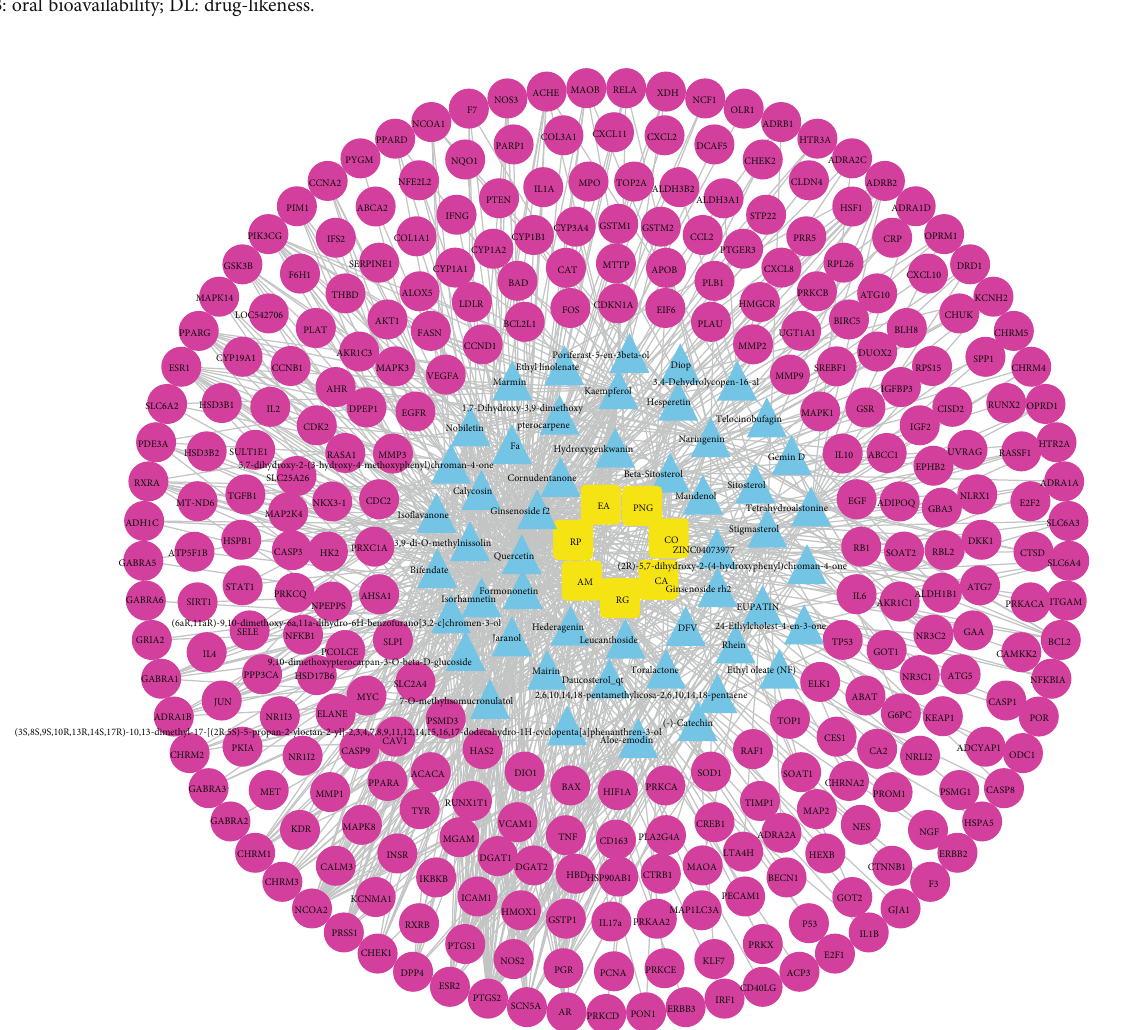
Figure 2: The herb-compound-target network was conducted for Tangshen Formula (TSF). The yellow rectangle nodes represent herbs (AM: Astragalus membranaceus ; CO: Cornus o ffi cinalis ; RG: Rehmannia glutinosa ; RP: Rheum palmatum ; PNG: Panax notoginseng ; EA: Euonymus alatus , CA: Citrus aurantium ). The blue triangle nodes represent compounds, the red circle nodes represent the potential targets, and the lines among inner nodes display the relationship among herbs, compounds, and